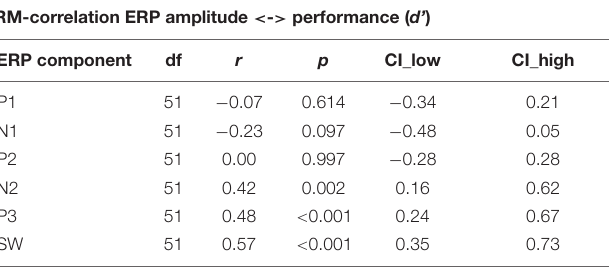
TABLE 3 | Correlation between amplitude of ERP components and performance ( d’ from SNBACK task) at baseline (T0). RM-correlation ERP amplitude < - > performance ( d’ ) ERP